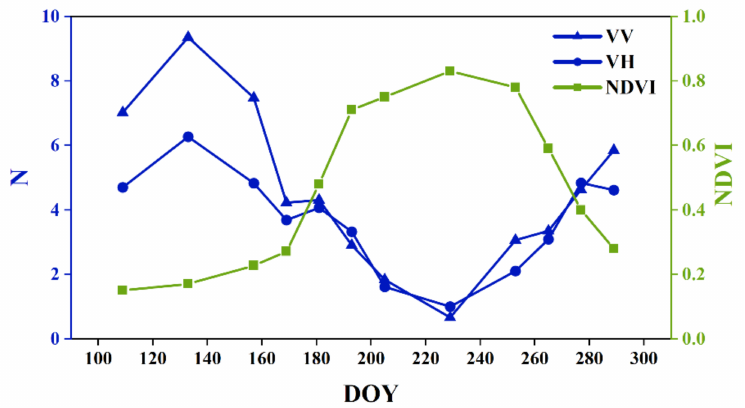
Figure 5. Time series relationship between N vv , N vh , and NDVI. N vv ( N vh ) represents the N value under VV (VH)